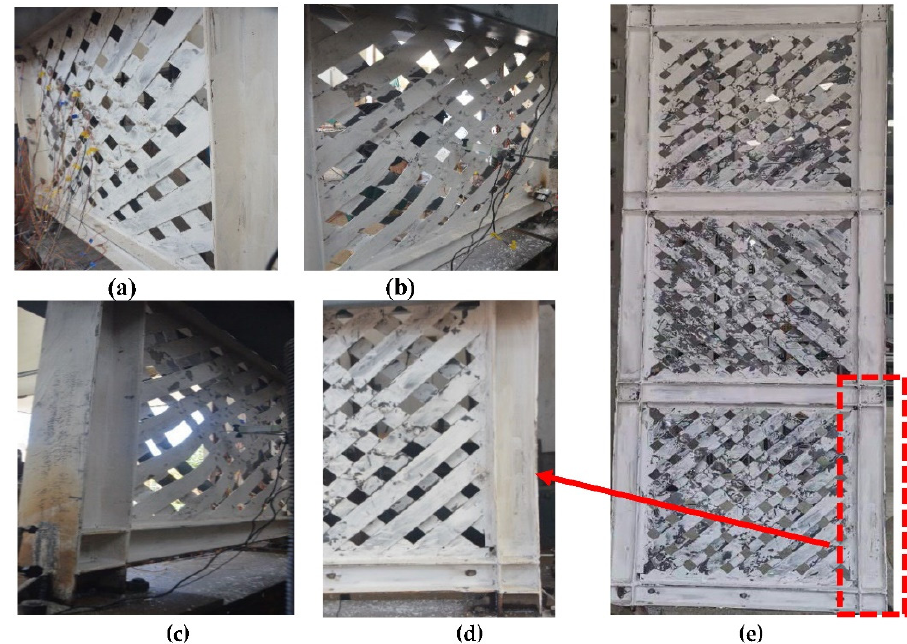
Figure 7. Details of IWS-SPSW specimen during the test: ( a , b ) first-floor buckling out-of-plane at cycle 7–19 (0.25–2% story drift), ( c , d ) yielding of the first-floor columns, ( e ) severe deformation of the specimen after the end of the test (3.3% story drift). Note: story drift is calculated based on the maximum roof displacement divided by wall height (= δ _max/h).